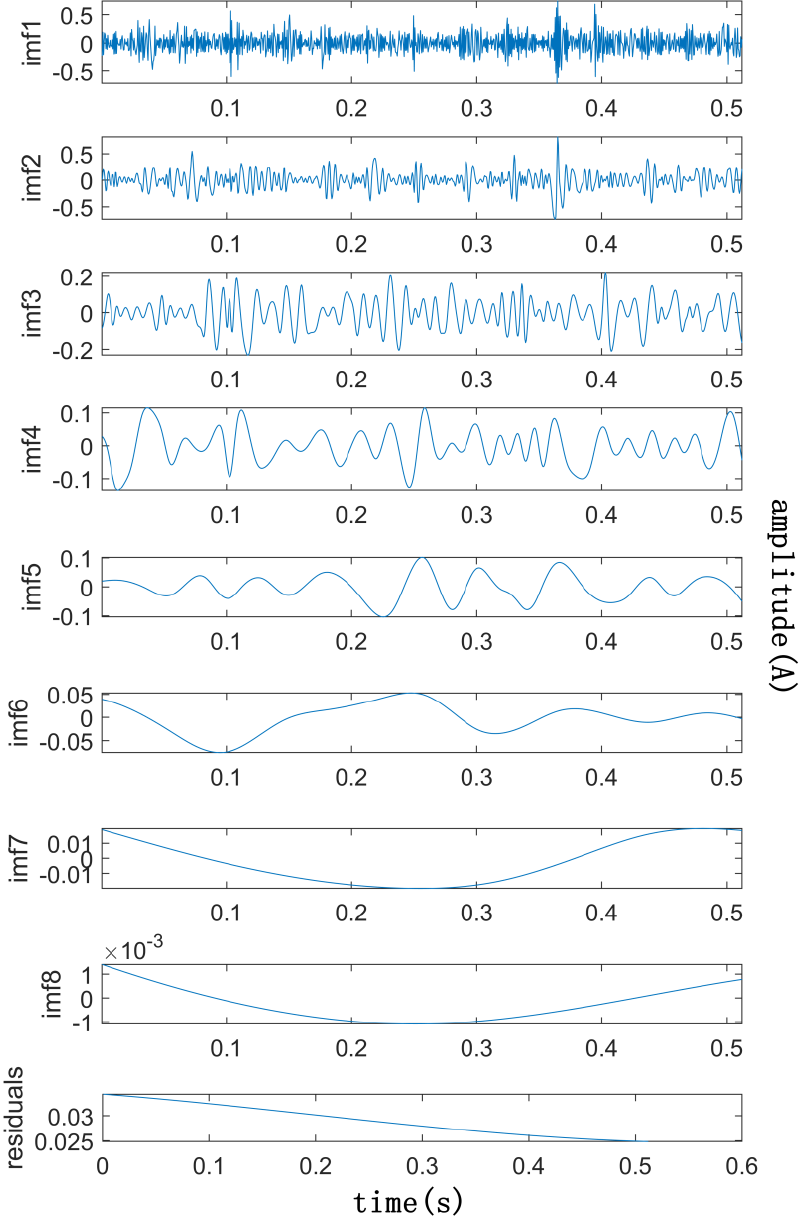
Figure 12. Time-domain diagram of EMD eigenmodes.